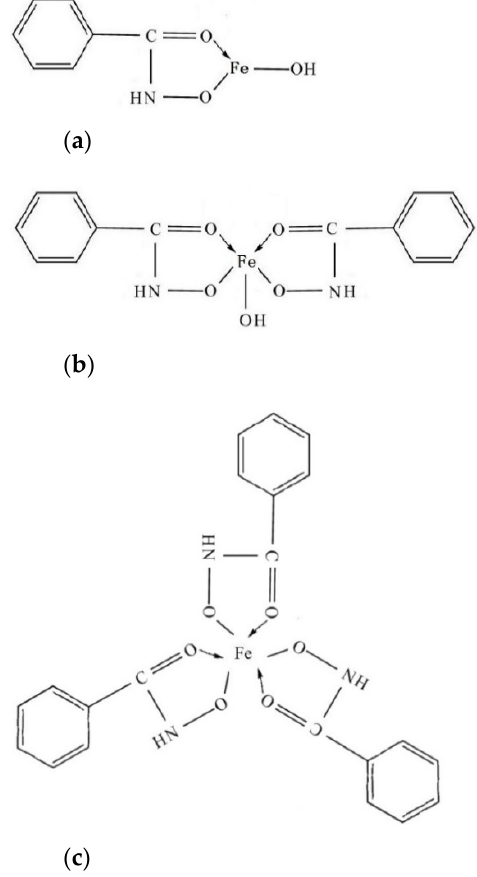
Figure 7. The main existence forms of the Fe-BHA chelates in slurry. ( a ) BHA:Fe=1:1; ( b ) BHA:Fe=2:1; ( c ) BHA:Fe=3:1.